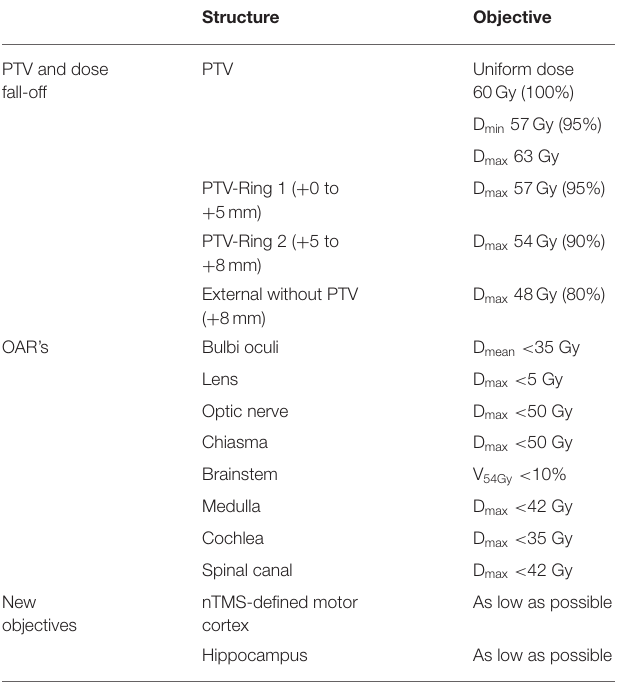
TABLE 1 | Standard optimization constraints for the “Original” plans and Auto-Planning plans.